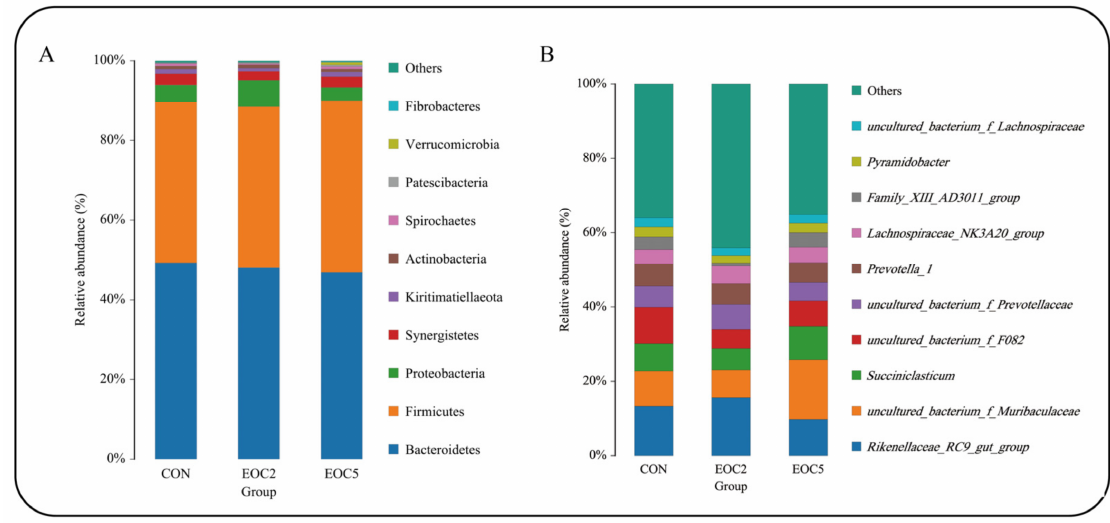
Figure 3. ( A ) Relative abundance of phylum horizontal species; ( B ) relative abundance of genus horizontal